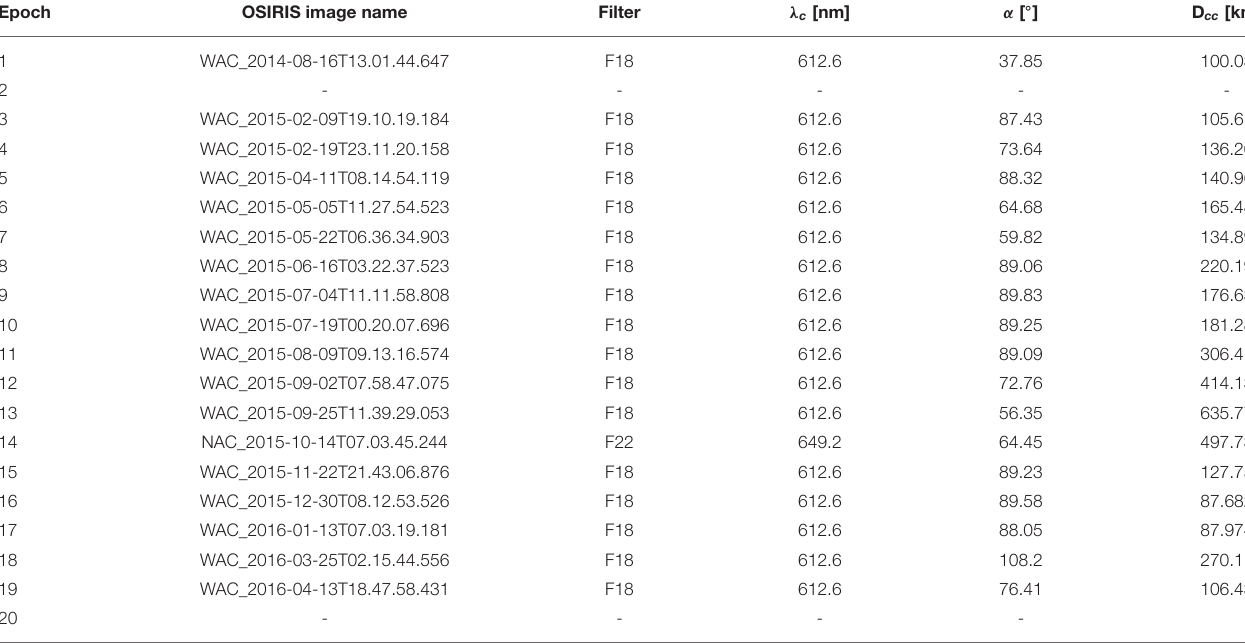
TABLE 4 | List of OSIRIS images used in each of the epochs as well as their filter, central wavelength ( λ c ), phase angle ( α ), and cometo-centric distance (D cc ).